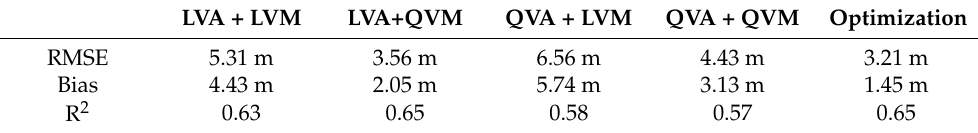
Figure 10. Density plots of forest height inversion results versus the LVIS RH100 metric over the BERMS site. Black lines are y = x and red lines are the linear fits. ( a ) LVA + LVM; ( b ) LVA + QVM; ( c ) QVA + LVM; ( d ) QVA + QVM; ( e ) Pixel-wise optimization. Table 3. Accuracy metrics of forest height inversion results over BERMS.